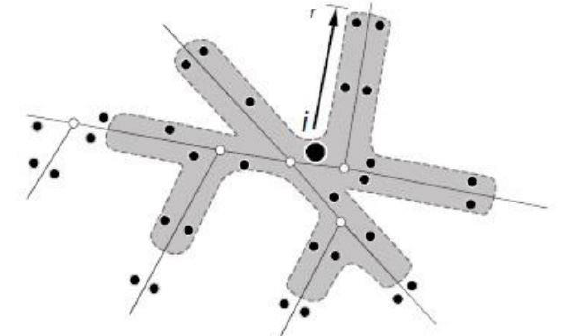
Figure 3. Reach index illustration (Sevtsuk and Mekonnen,